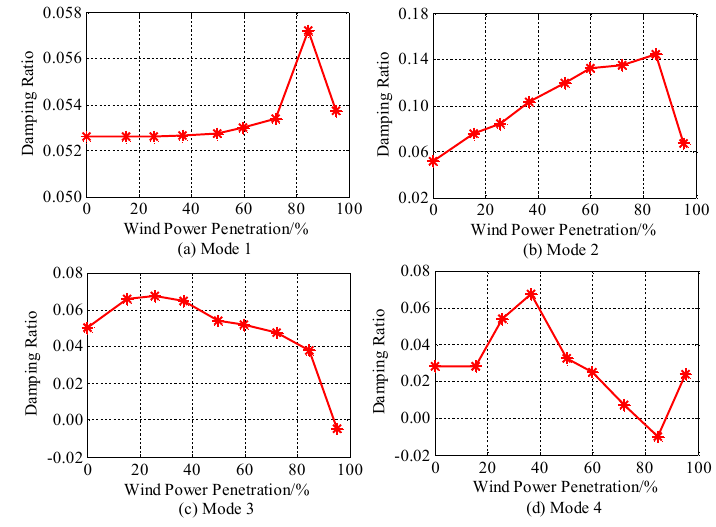
Figure 3. Damping ratios of interarea modes. ( a ) Mode 1; ( b ) Mode 2; ( c ) Mode 3; ( d ) Mode 4.